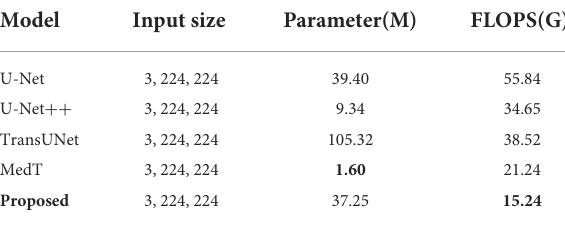
TABLE 3 Comparison of the model size and flops cost.